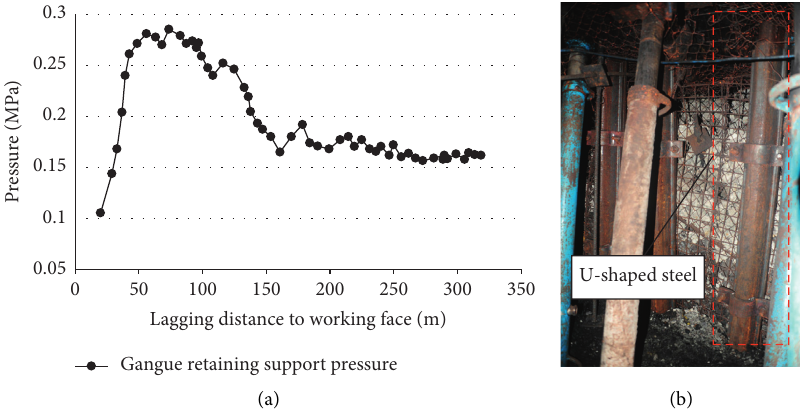
Figure 12: Monitoring results of gangue retaining support. (a) Gangue retaining support pressure. (b) Field effect of gangue retaining support.